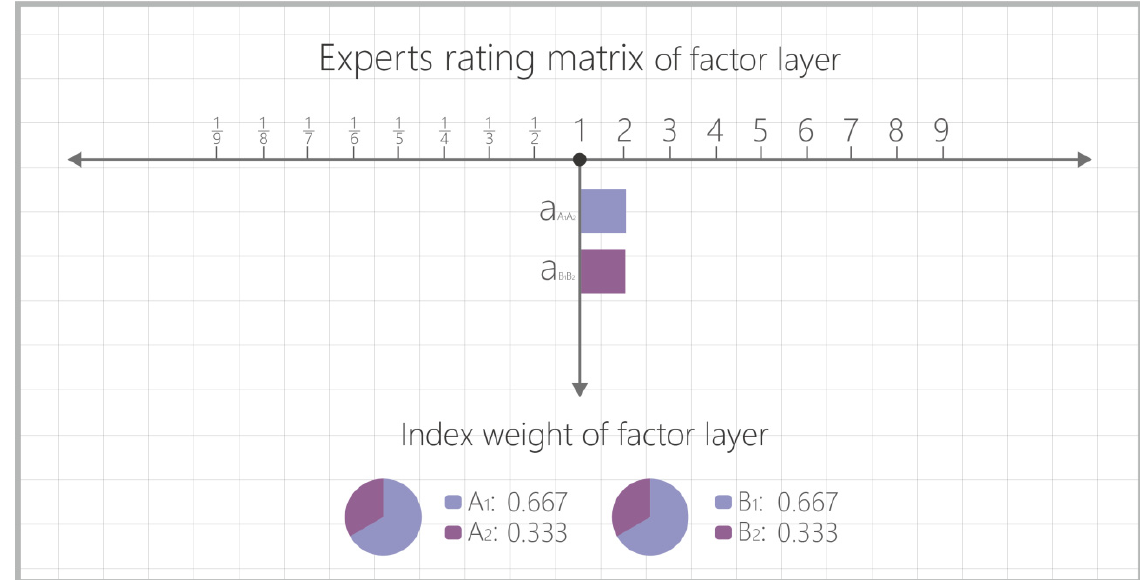
Figure 7. Experts’ rating judgment and index weight of factor layer.